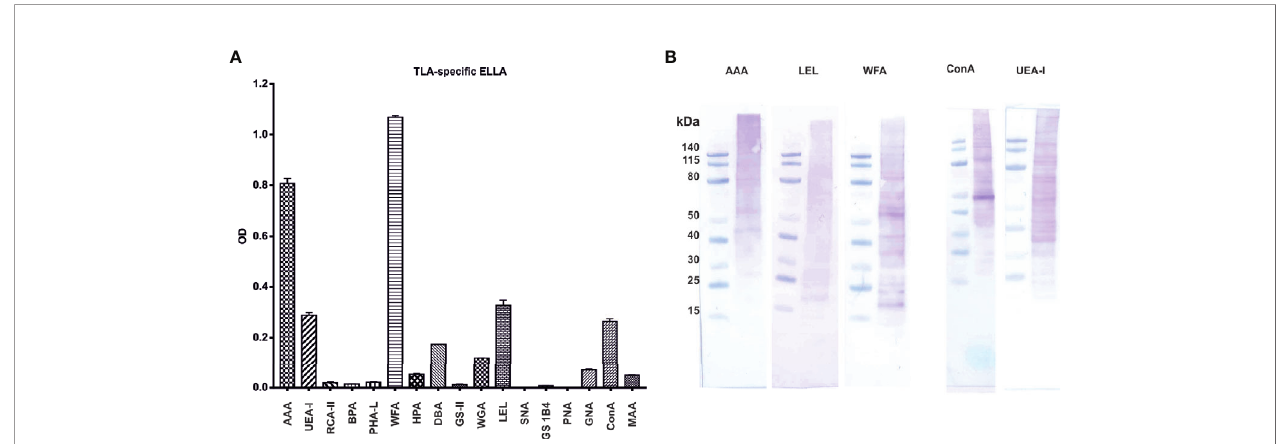
FIGURE 6 | Characterization of TLA with enzyme-linked lectin assay (ELLA) and lectin-Western blots reveal a complex pattern of epitope sugars: (A) abundance of tachyzoite lysate antigen ’ s (TLA)s epitope sugars evaluated with ELLA. (B) Distribution of epitope sugars on proteins and peptides of TLA. AAA Anguilla anguilla agglutinin; UEA-I Ulex europaeus agglutinin-I; RCA-II Ricinus communis agglutinin II; BPA Bauhinia purpurea agglutinin; PHA-L phytohemagglutinin; WFA Wisteria fl oribunda agglutinin; HPA Helix pomatia agglutinin; DBA Dolichos bi fl orus agglutinin; GS-II Griffonia simplicifolia agglutinin; WGA Wheat germ agglutinin; LEL Lycopersicon esculentum lectin; SNA Sambucus nigra agglutinin; GS1B4 Griffonia simplifolica -1B4; PNA peanut agglutinin; GNA Galanthus nivalis agglutinin; ConA Concanavalin A; MAA Maackia amurensis agglutinin. TLA , tachyzoites lysate antigen; OD , optical